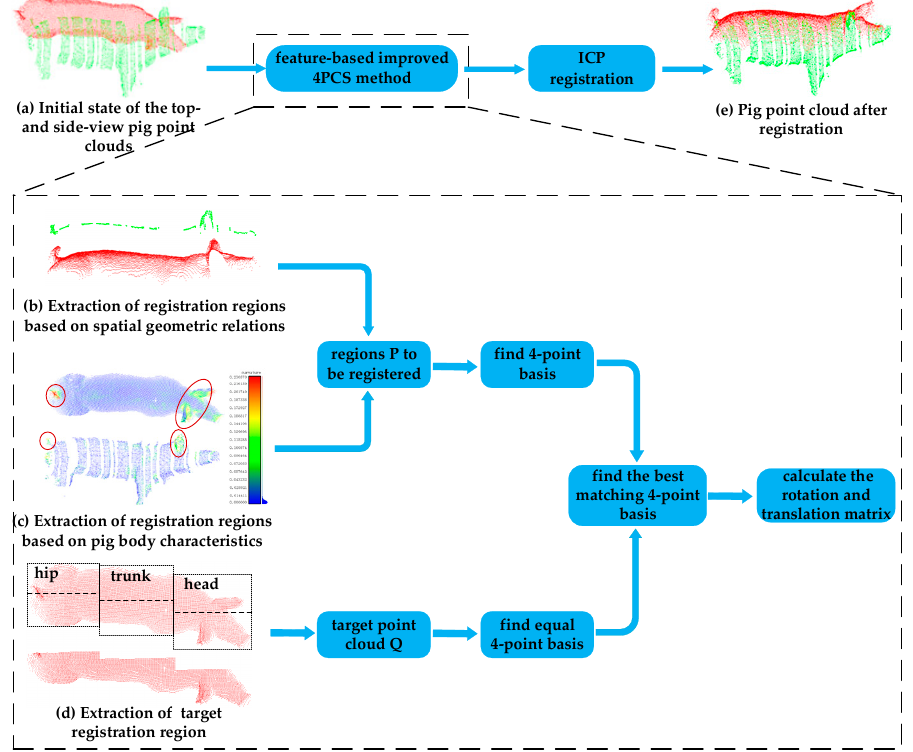
Figure 4. Illustration of the registration process for two-view pig point clouds. The top-view point cloud is shown in red, and the side-view point cloud is shown in green. ( a ): Initial state of the top- and side-view pig point clouds; ( b ): Extraction of registration regions based on spatial geometric relations; ( c ): Extraction of registration regions based on pig body characteristics; ( d ): Extraction of target registration region; ( e ): Pig point cloud after